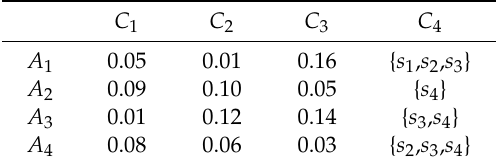
Table 3. Law enforcement possibility evaluation matrix of judgment debtors.